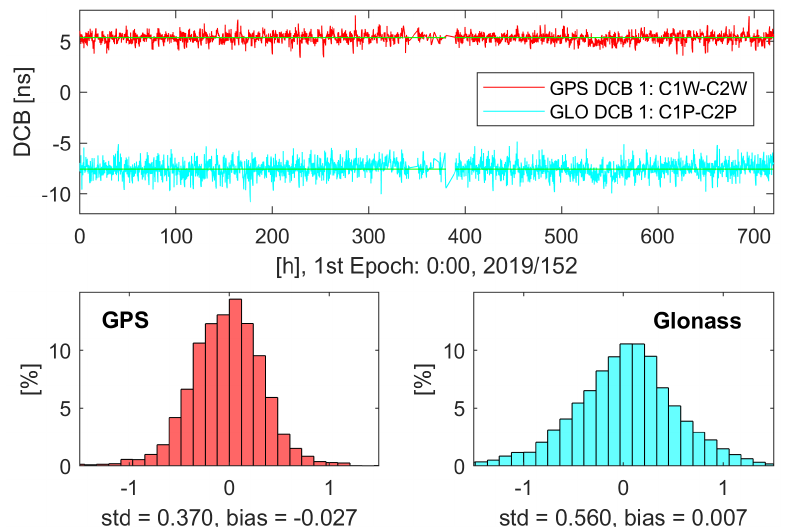
Figure 9. ( Top ) Estimated receiver DCBs for GPS (red) and Glonass (cyan) of the PPP solution using the uncombined model with Regiomontan as ionospheric constraint for December 2019. The CODE estimation of the receiver DCBs is shown in green. ( Bottom ) Histogram of the difference to the CODE estimation with the corresponding standard deviation (std) and bias.